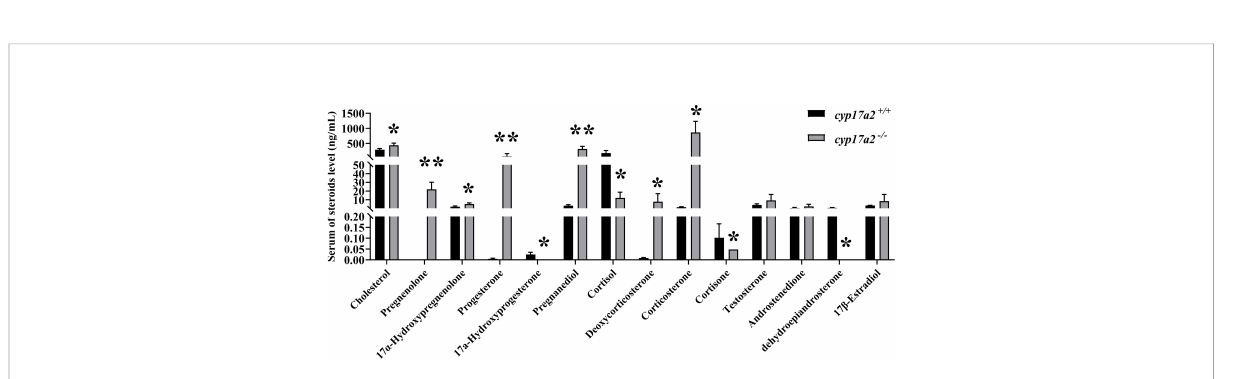
FIGURE 5 Mutation of cyp17a2 resulted in disordered steroidogenesis in male tilapia. Serum steroid levels of cyp17a2 +/+ (n=3) and cyp17a2 -/- (n=3) fi sh were measured by LC-MS/MS. The data are reported as the means±SD. Asterisk above the error bar indicate signi fi cant differences between groups tested by Student ’ s t -test (*, P<0.05; **, P<0.01).